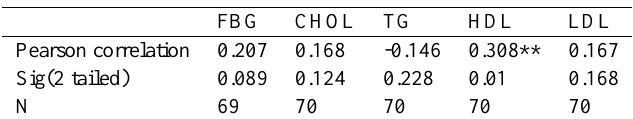
Table 5: The correlation between HbA1c with FBS and